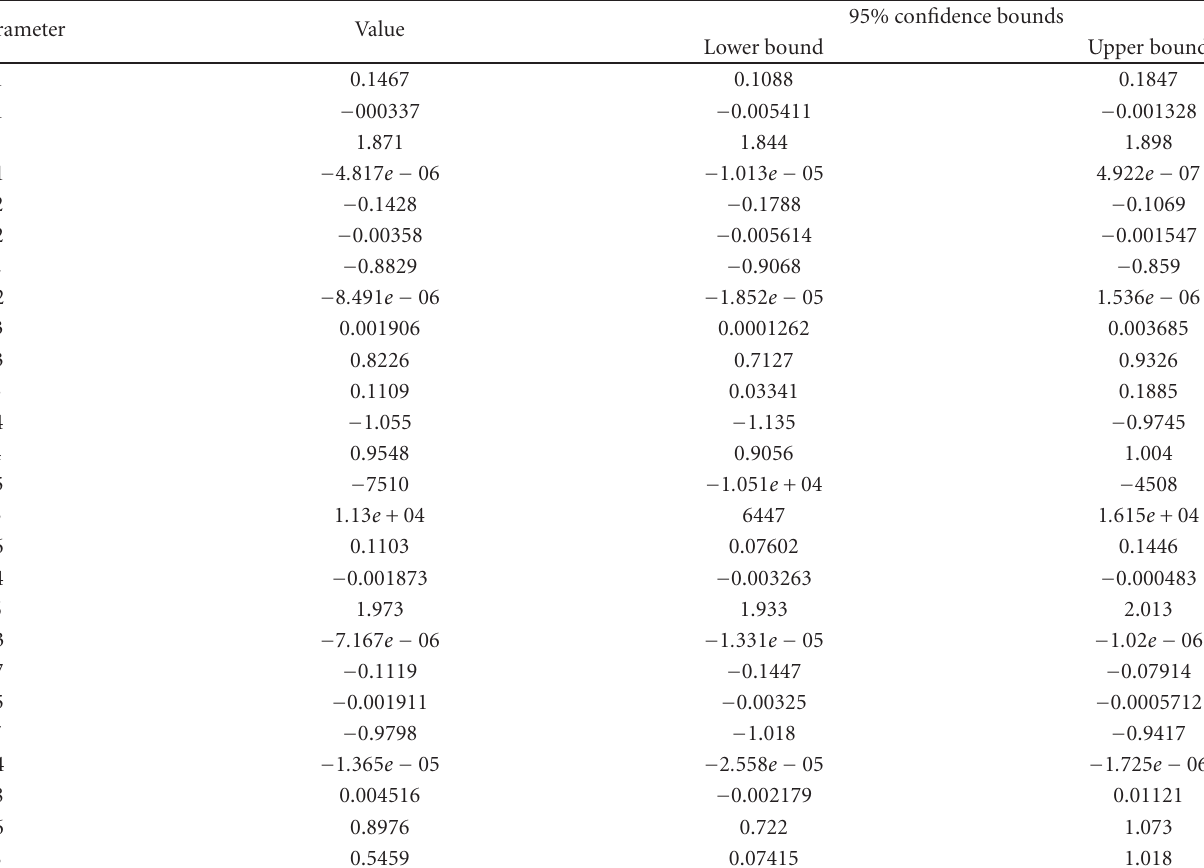
Table 1: Parameters of the state equations (7)–(9) [2].